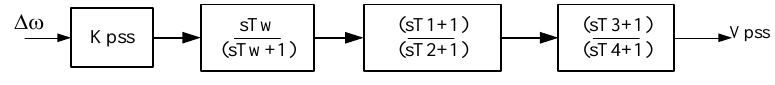
Figure 1. Single-input power system stabilizer lead-lag structure.